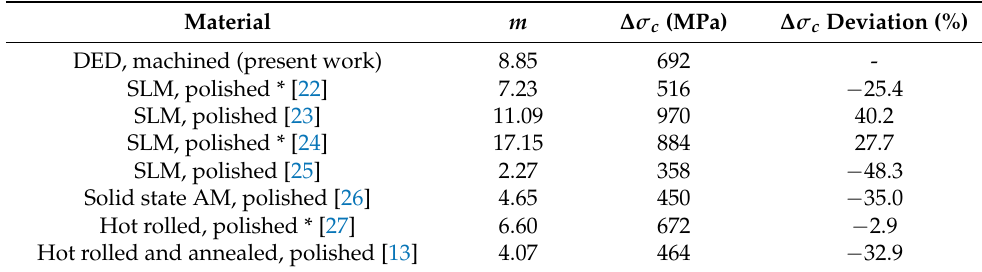
Table 6. Fatigue properties comparison.